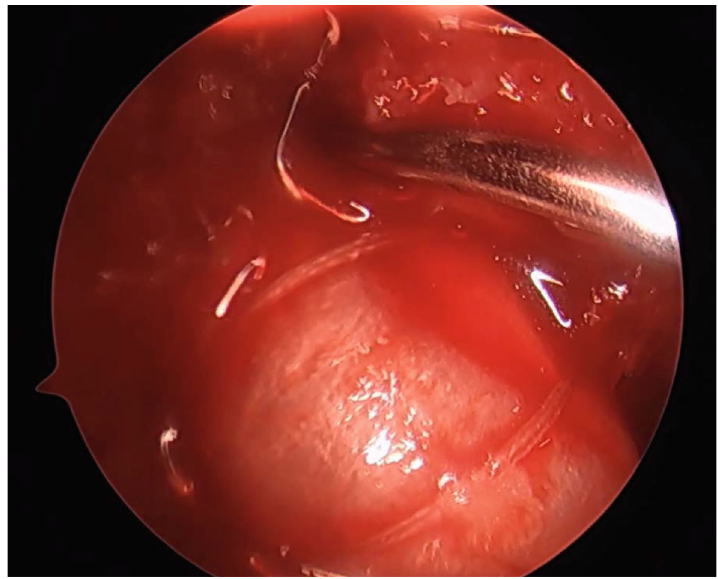
Figure 4: Under a dry environment, the remaining PRP is injected into the bone tunnels as well as within the collagen